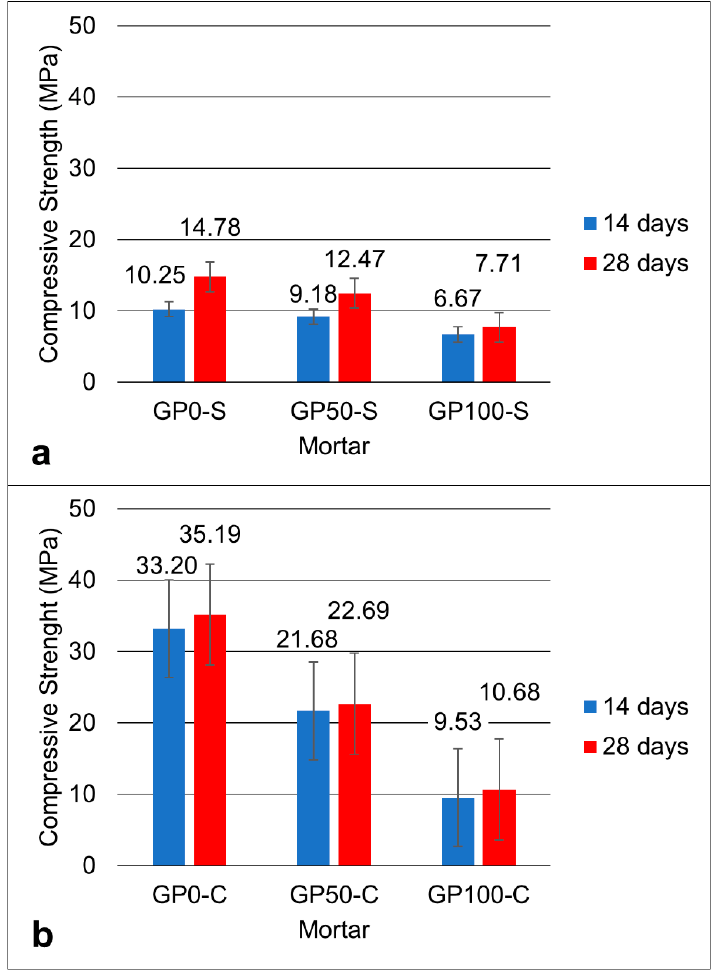
Figure 5. Graph of the compressive strength of the GP-S ( a ) and GP-C ( b ) mortars.